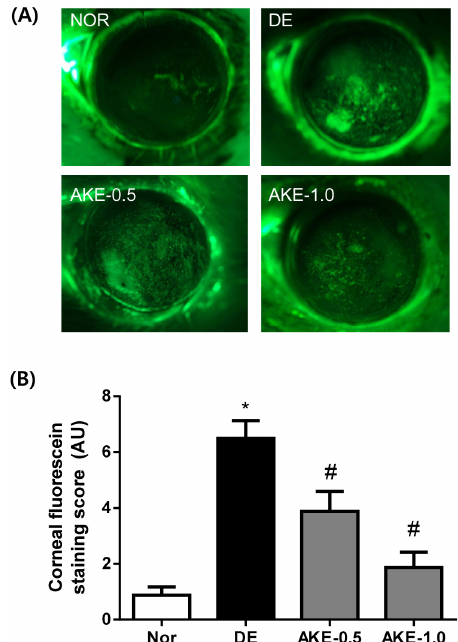
Figure 3. Effects of AKE on corneal epithelial damage. ( A ) Fluorescent slit ‐ lamp photographs of mouse eyes with or without AKE treatment; ( B ) Corneal fluorescein grading score after the topical application of AKE. The values in the bar graph represent the mean ± SE, n = 10. * p < 0.05 vs. normal mice, # p < 0.05 vs. vehicle ‐ treated dry eye mice.